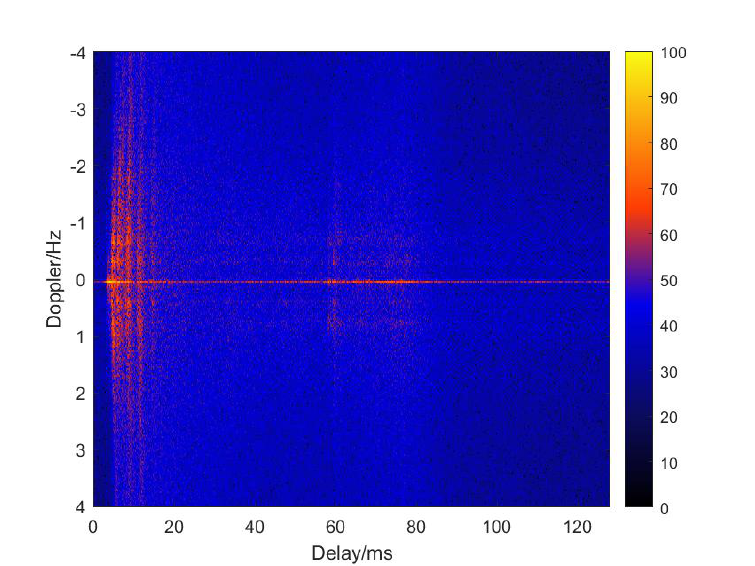
Figure 8. CIR in DD domain under NOF